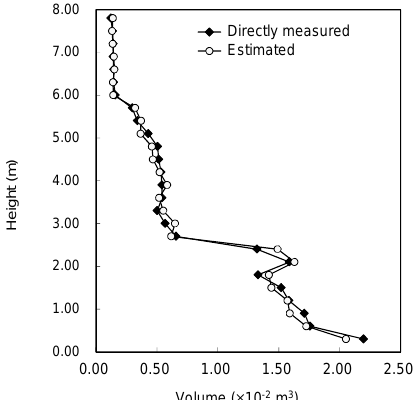
Figure 7: The estimated volume of the stem and large branches, the estimated volume of the small branches, and the estimated total volume, derived from the voxel-based solid model by counting voxels in each 1.0-m height interval (Hosoi et al., 2013).